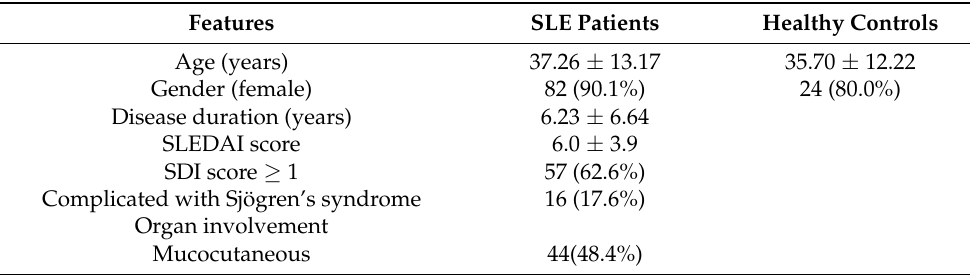
Table 1. Demographics of SLE patients and